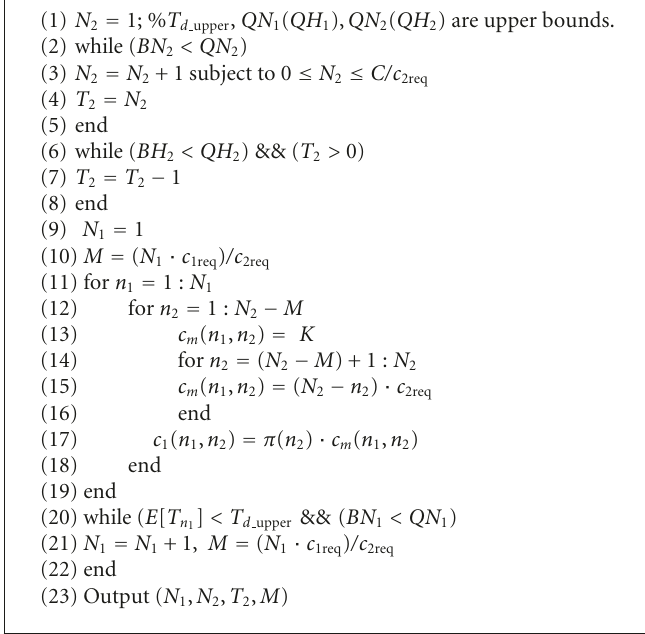
Algorithm 1: Determining algorithm of optimal number of the prioritized and nonprioritized